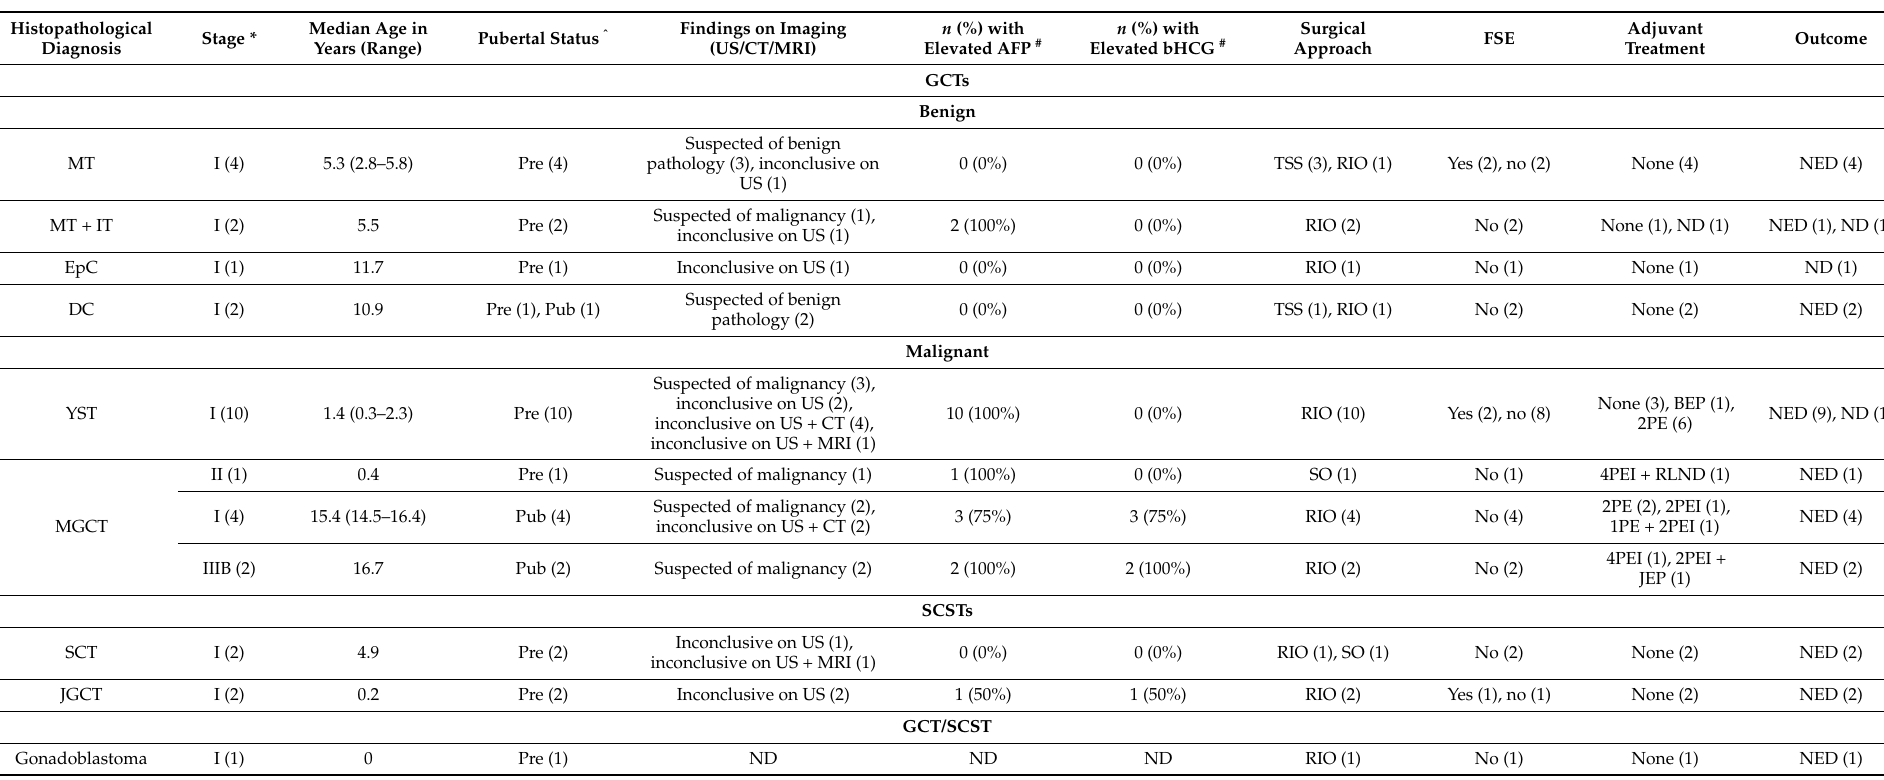
Table 2. Stage of disease, pubertal status, diagnostic findings, TSS, use of FSE, adjuvant treatment, and outcome for boys with a testicular tumor. Histopathological